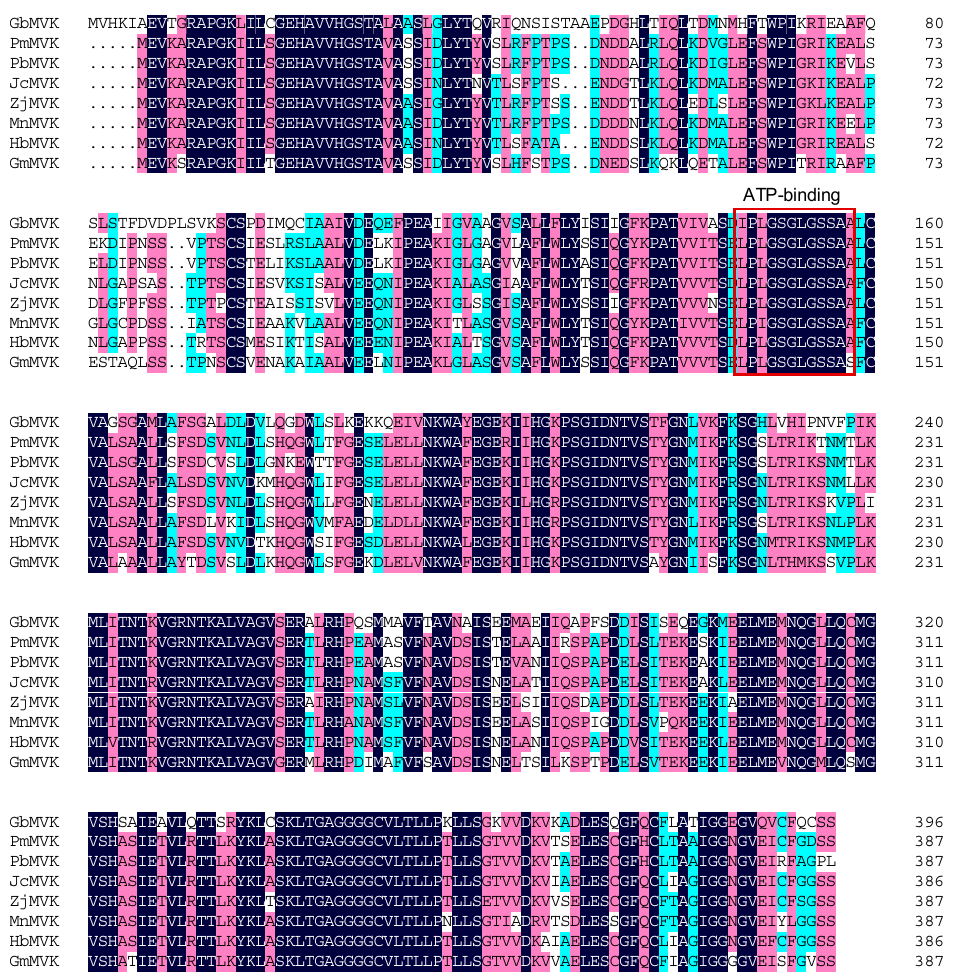
Figure 3. Multiple alignments of GbMVK with MVK proteins from Prunus mume (PmMVK, Accestion No. XP_008246488.1), Pyrus × bretschneideri (PbMVK, Accestion No. XP_009349394.1), Jatropha curcas (JcMVK, Accestion No. XP_012089078.1), Ziziphus jujuba (ZjMVK, Accestion No. XP_015875214.1), Morus notabilis (MnMVK, Accestion No. XP_010105842.1), Hevea brasiliensis (HbMVK, Accestion No. AIO11226.1), Glycine max (GmMVK, Accestion No. NP_001276217.1). Dark blue: identity = 100%; red: 75% ≤ identity < 100%; light blue: 50% ≤ identity < 75%.